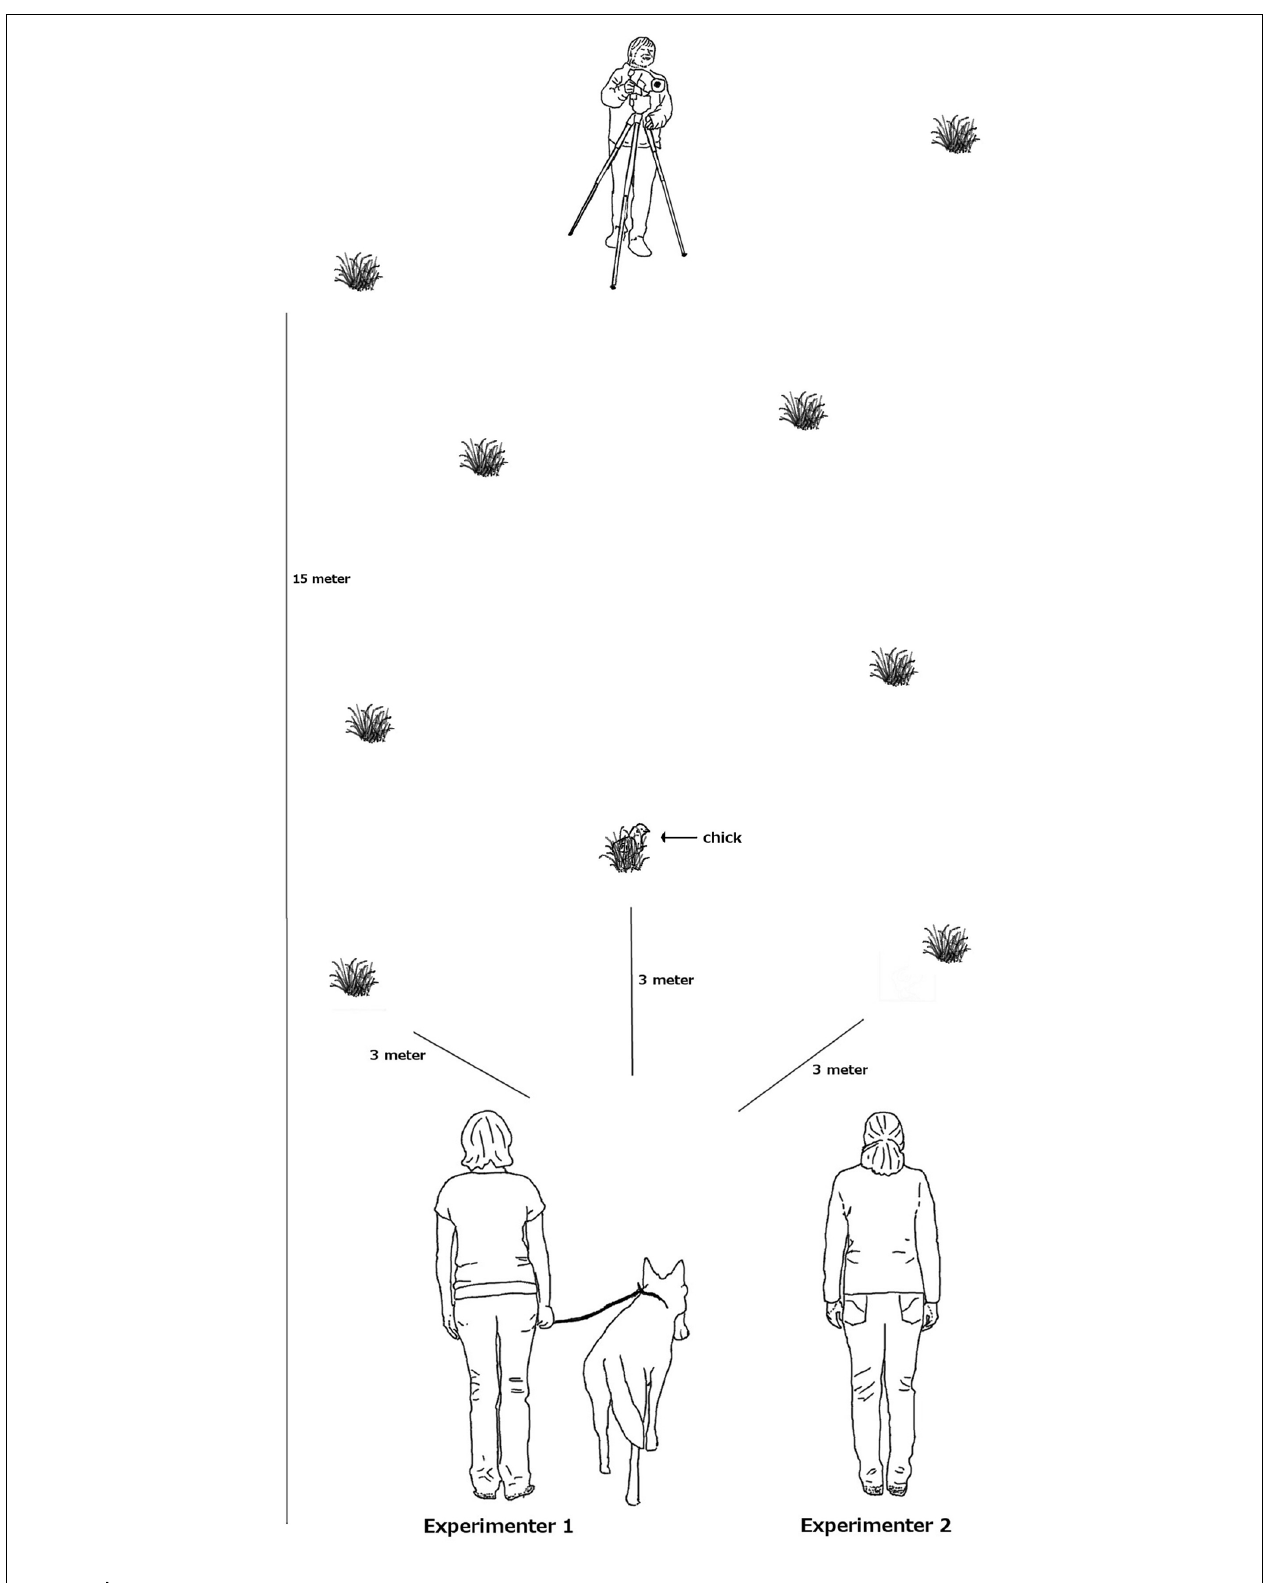
FIGURE 1 | Experimental